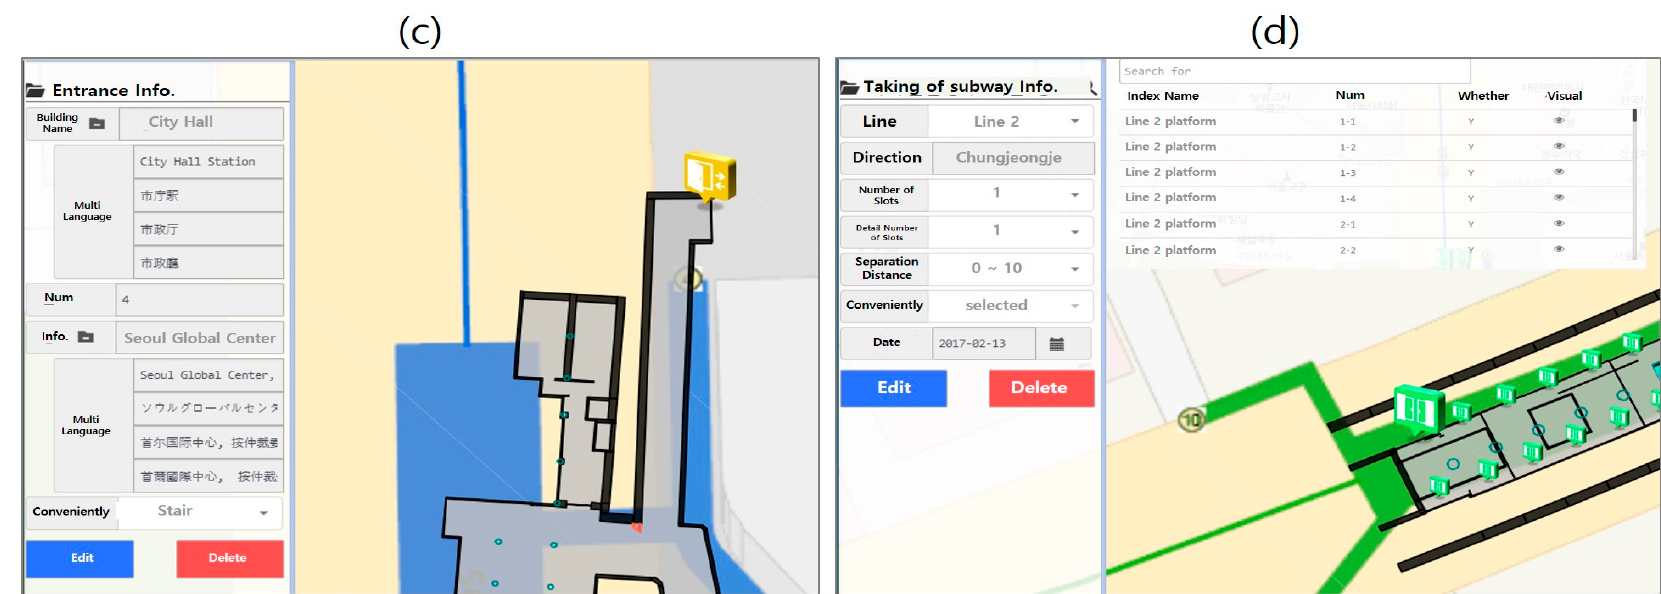
Figure 5. Management cases on indoor POI detail information: ( a ) facilities, ( b ) shopping center, ( c ) entrances, and ( d ) subway.